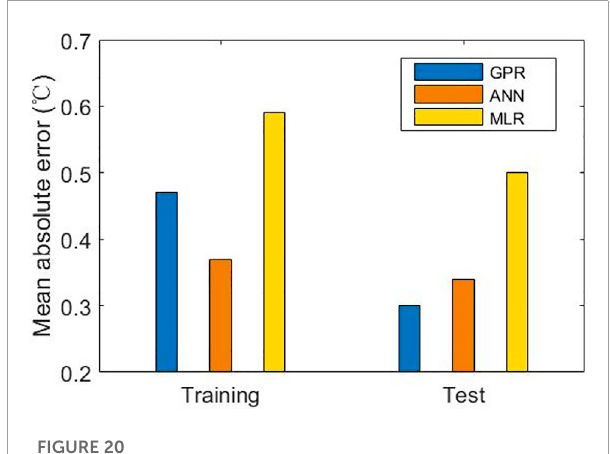
FIGURE 20 Comparison of prediction accuracy in terms of MAE.